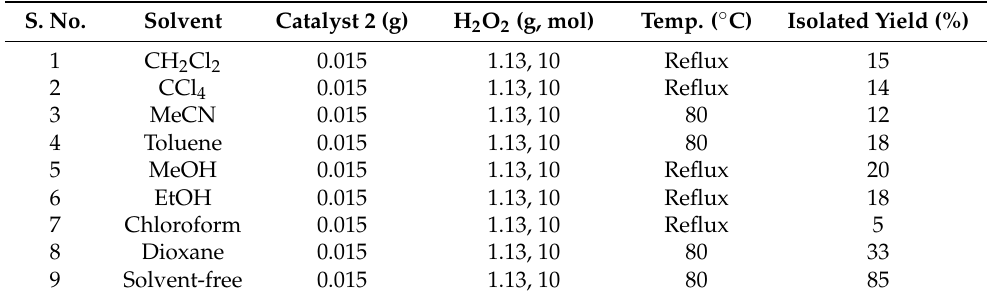
Table 1. Screening of multicomponent Biginelli reaction under different solvent as well as solvent-free conditions.